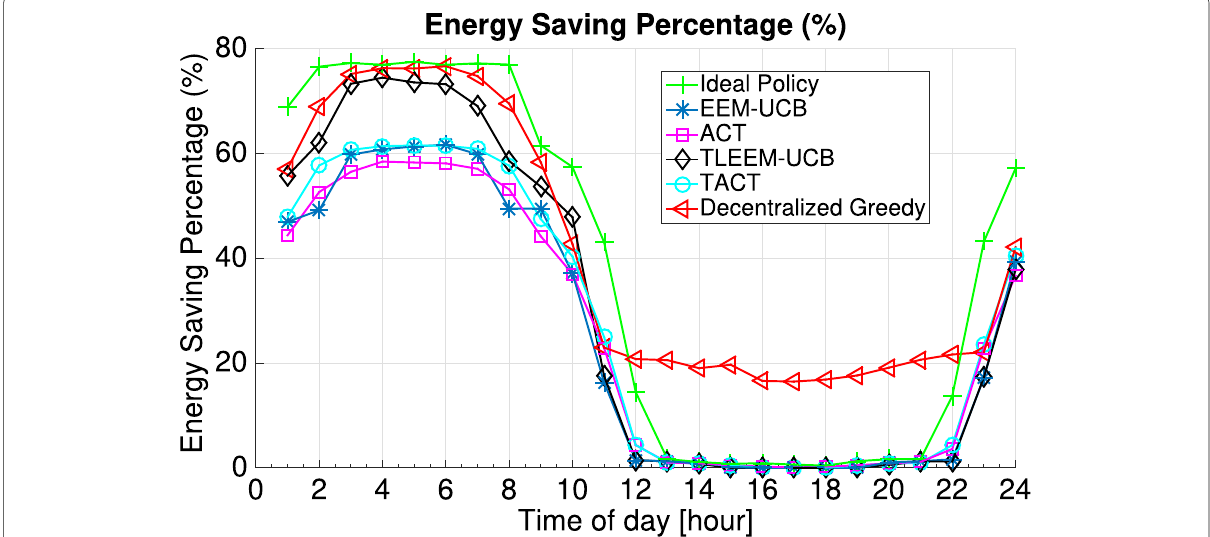
Fig. 8 Average percentage of energy saving achieved by several learning algorithms with respect to time of day. The figure compares the energy saving percentage w.r.t. full deployment scenario achieved by several learning policies in function of daytime. The gain in energy consumption is plotted from 1:00 am to 24:00